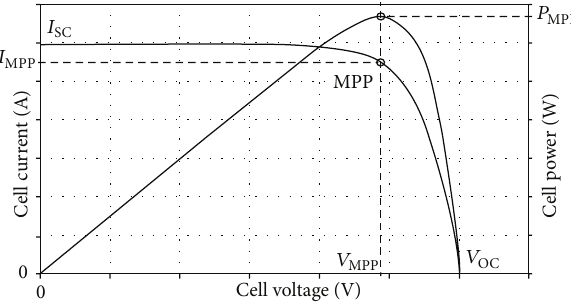
Figure 5: 𝐼 - 𝑉 and 𝑃 - 𝑉 characteristics of a solar cell [29].